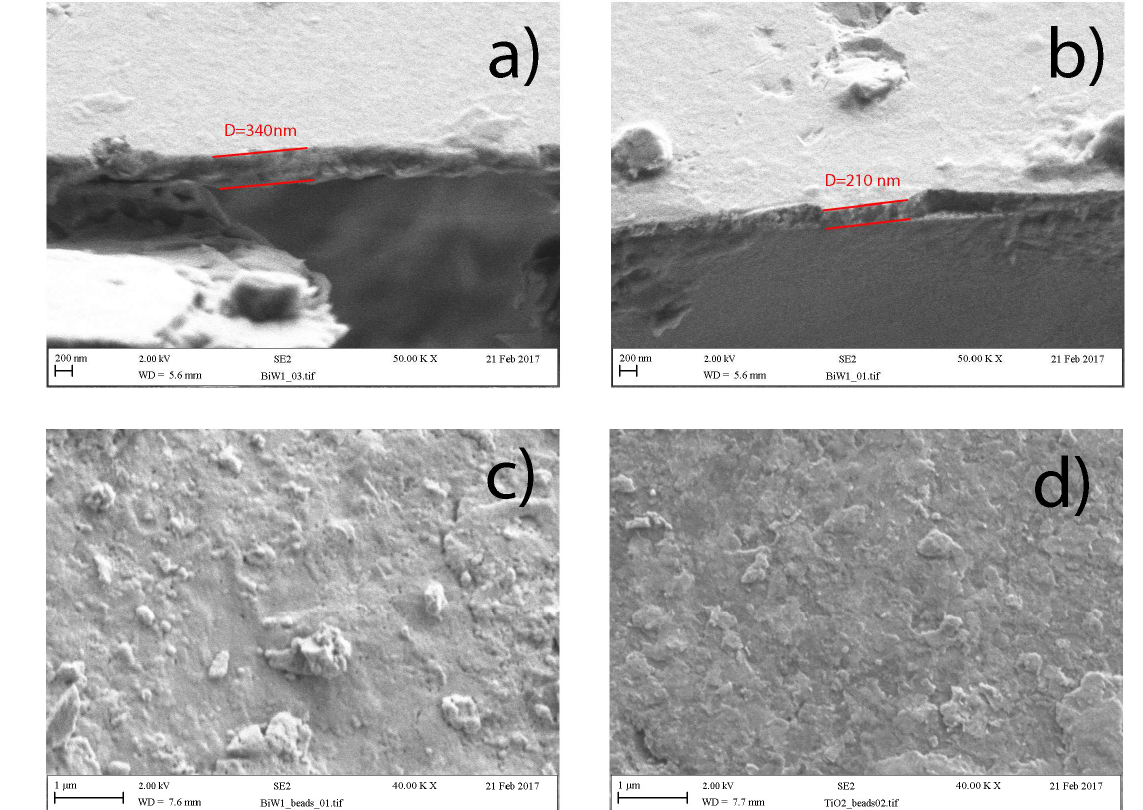
Figure 1. Cross-section SEM images of the coatings ( a ) Bi0, ( b ) BiW1 and top view SEM images of the coatings ( c ) BiW2, and ( d ) TiO 2 .